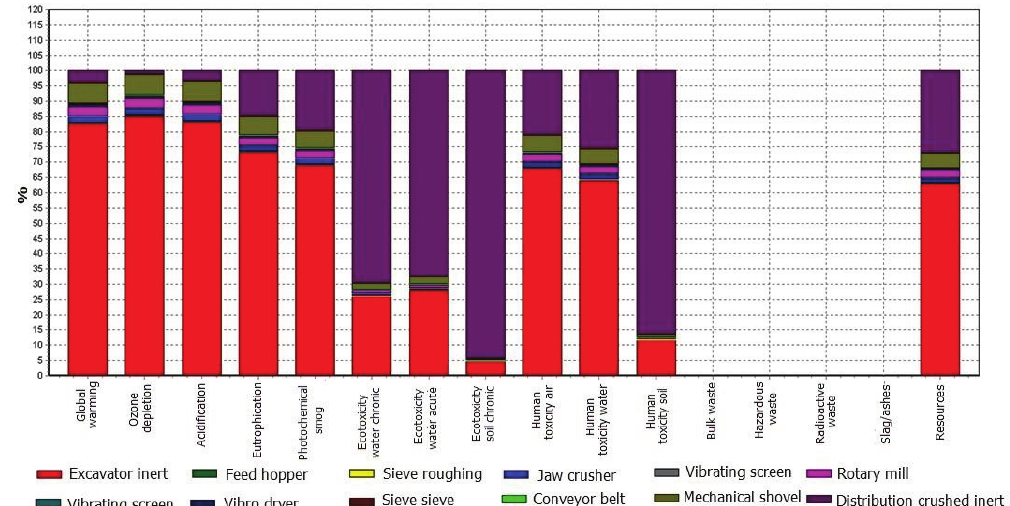
Fig. 10. Characterization of individual impacts for each phase of scenario 1 with EDIP/UMIP method